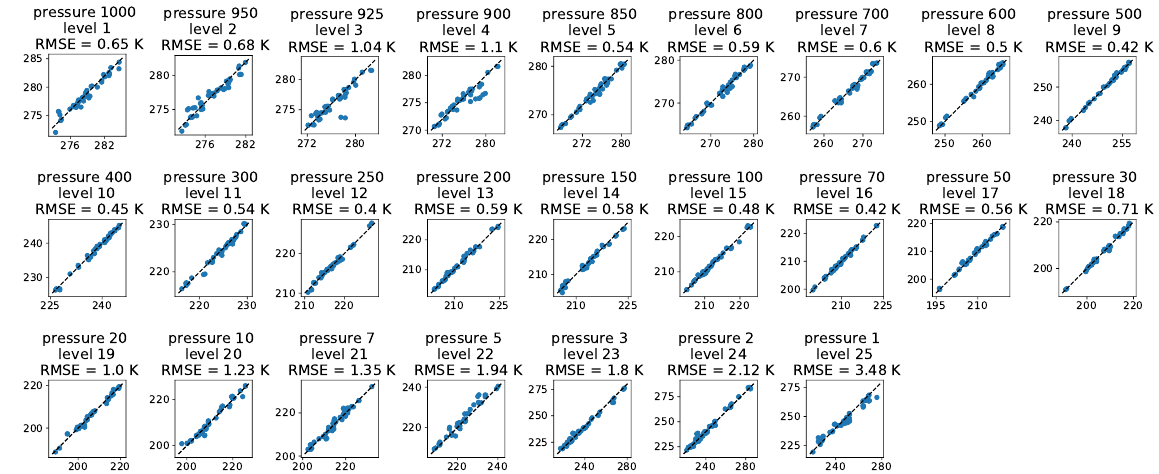
Figure 8. Comparison of CAMS ( y -axis) and in-product ( x -axis) meteorological data—temperature profile at pressure